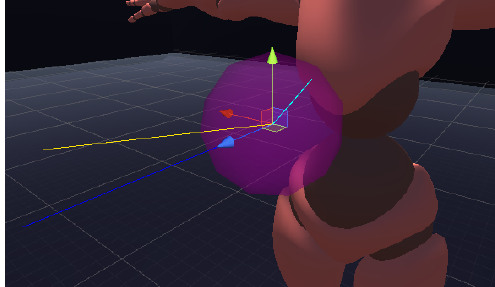
Figure 4. Forces decomposition in the simulator. In blue , original force; cyan : random point added to the original force; yellow : normalized addition of previous forces (final force